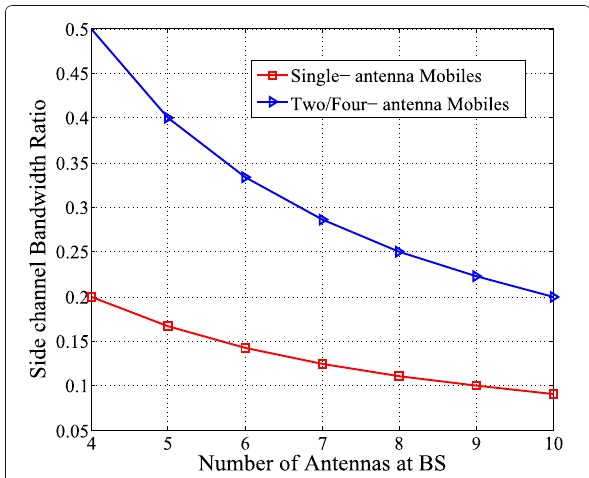
Fig. 13 The required side-channel bandwidth ratio to compensate for CSIT as a function of the number of antennas at the BS with equal number of antennas at mobiles when α S = M 2